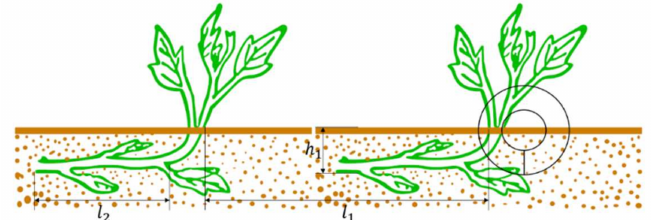
Figure 2. Schematic diagram of horizontal planting of bare sweet potato seedlings.